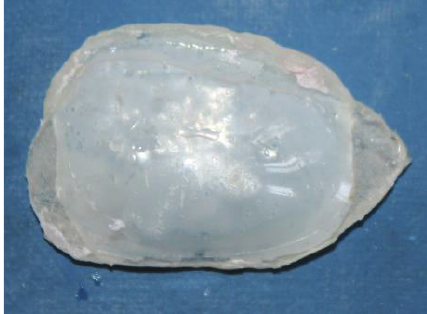
Figure7:ArticulationandarrangementofteethinHanauWideVue Articulator.